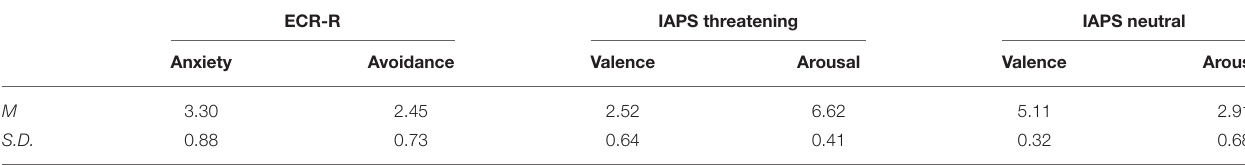
TABLE 1 | Mean and SD of attachment orientations and prime stimulus in the two conditions.